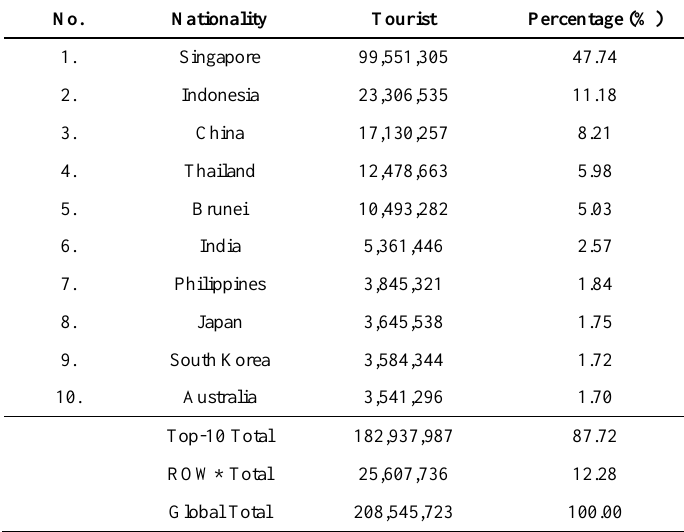
Figure 3. Impact of MCO on the Tourism Sector. Table 1. International Tourist Arrivals in Malaysia.